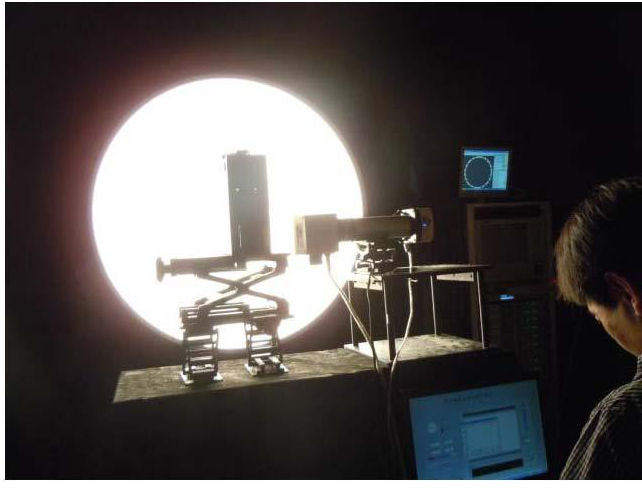
Figure 10. Overview of the calibration experiment: the SVC HR1024 was in front of the integrating sphere (left) and the calibrated FISS system (right). Both were close, and operating simultaneously. The SVC HR1024 was used to cross-calibrate the FISS system, and both were fully illuminated by the integrating